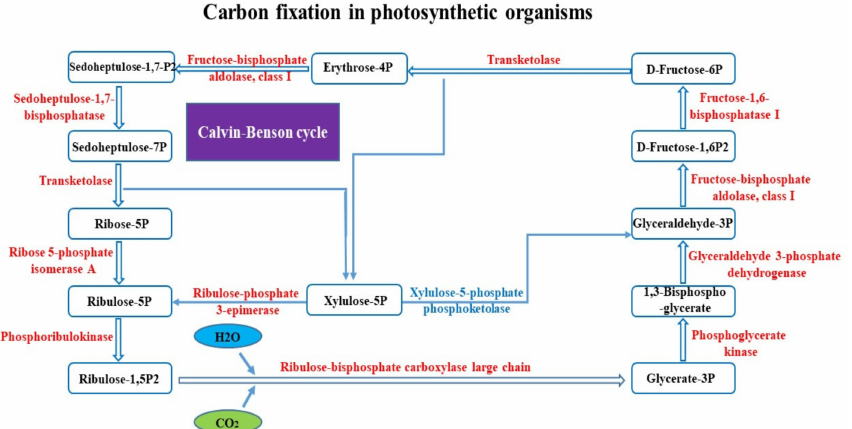
Figure 4. DEGs involved in “carbon fixation pathway in photosynthetic organisms” from blanched stem of water dropwort (post-blanching